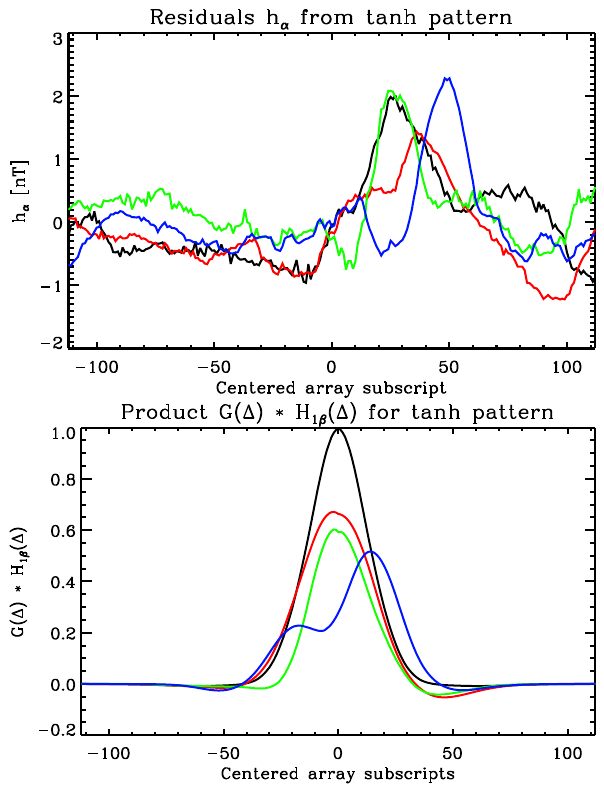
Fig. 5. Crossing time error analysis using a tanh pattern function. Top: residuals computed from the Cluster FGM data and tanh pat- tern functions in Fig. 4 as functions of centered array subscripts. The total time window is 10s (sampling interval 44.6ms). Bottom: products of correlation functions G(1) and H αβ (1) that enter the sum in the crossing time error formula (52). Shown are the profiles for α = 1. The four colors correspond to spacecraft no. β as listed in the caption of Fig. 4.